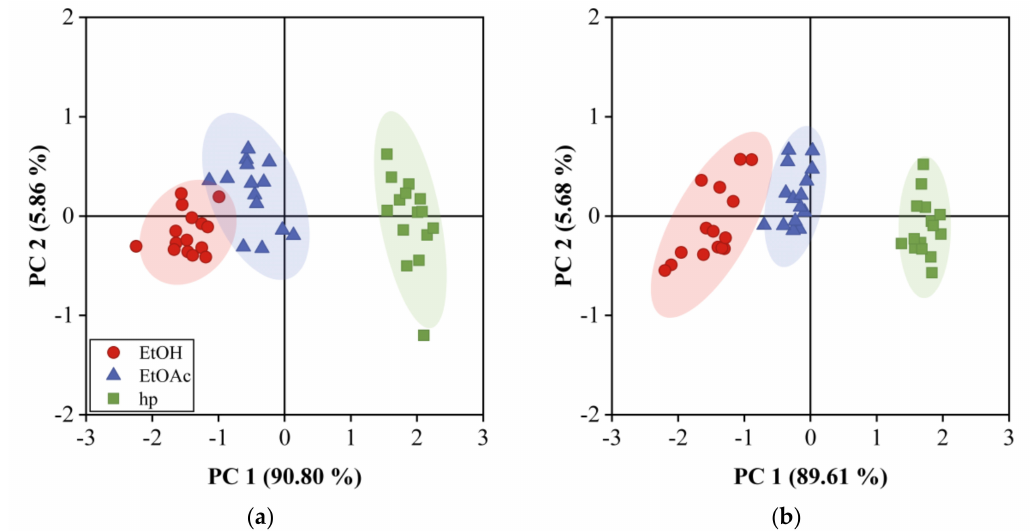
Figure 9. PCA results of partition coe ffi cient ln ( K ) for QCM gas sensor array. ( a ) 12QCM-SA and ( b ) 30QCM-SA.